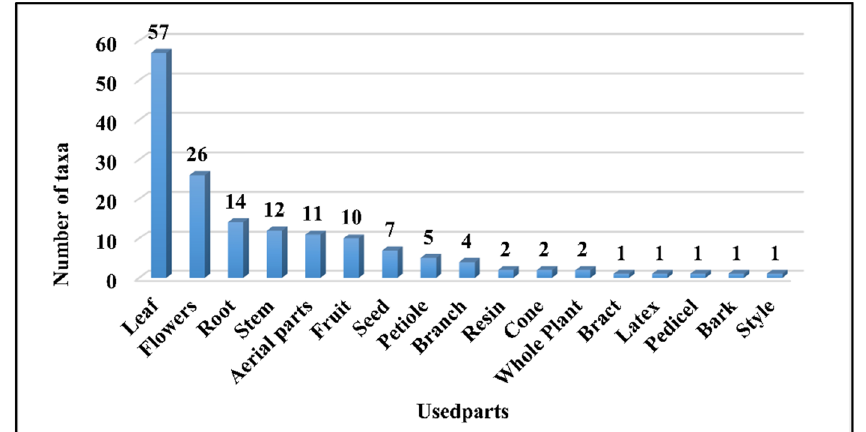
Figure 5: Plant parts